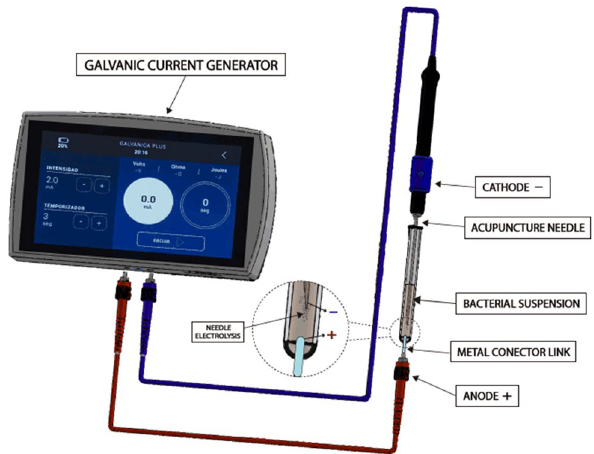
Figure 2. Procedure for PNE in vitro. Galvanic currents generate a cathodic flow in the bacterial